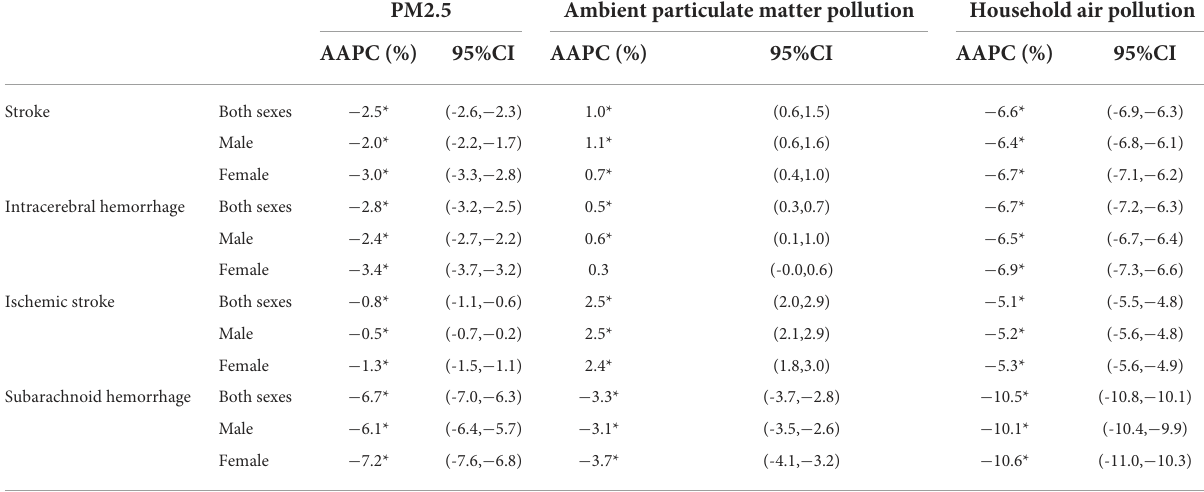
TABLE 1 The results by Joinpoint regression analysis on the mortality rate of stroke, intracerebral hemorrhage, ischemic stroke and subarachnoid hemorrhage attributable to PM2.5 exposure from 1990 to 2019.